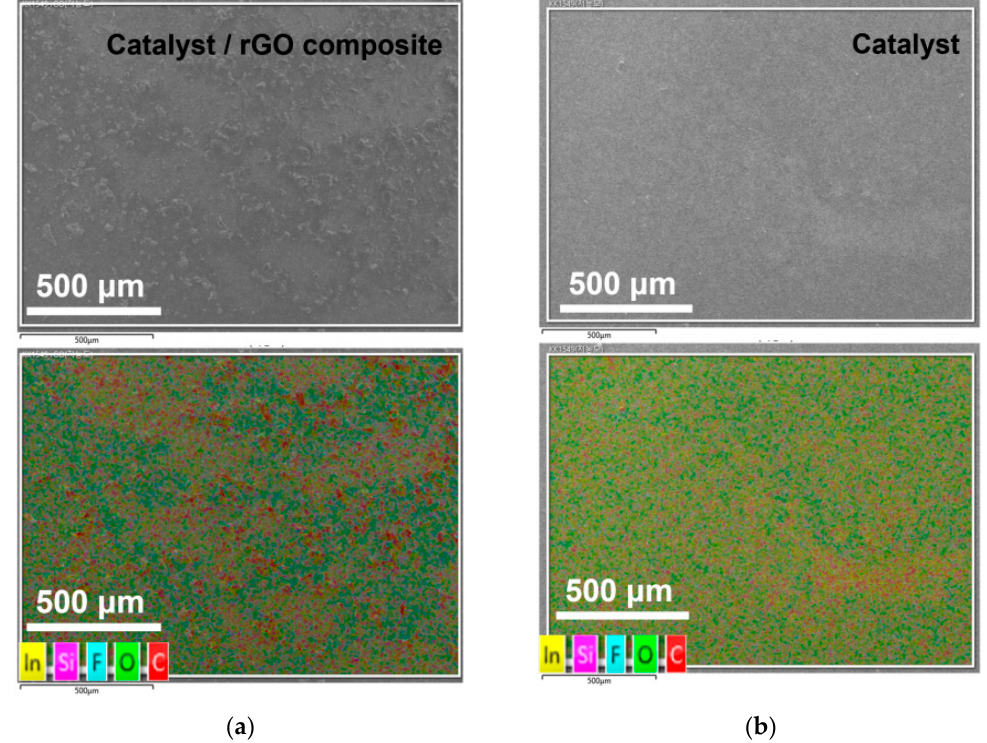
Figure 5. SEM and EDS analyses of ( a ) the catalyst/rGO composite-modified and ( b ) catalyst-modified GCEs. The red color in the bottom images is the element mapping for C.